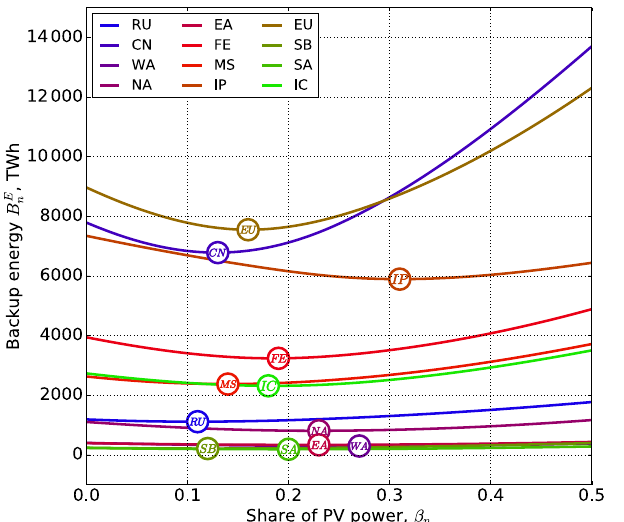
Figure 2. Backup energy need in dependency of the correspond- ing wind/PV mix. Markers are placed at the position of the optimal power mix.